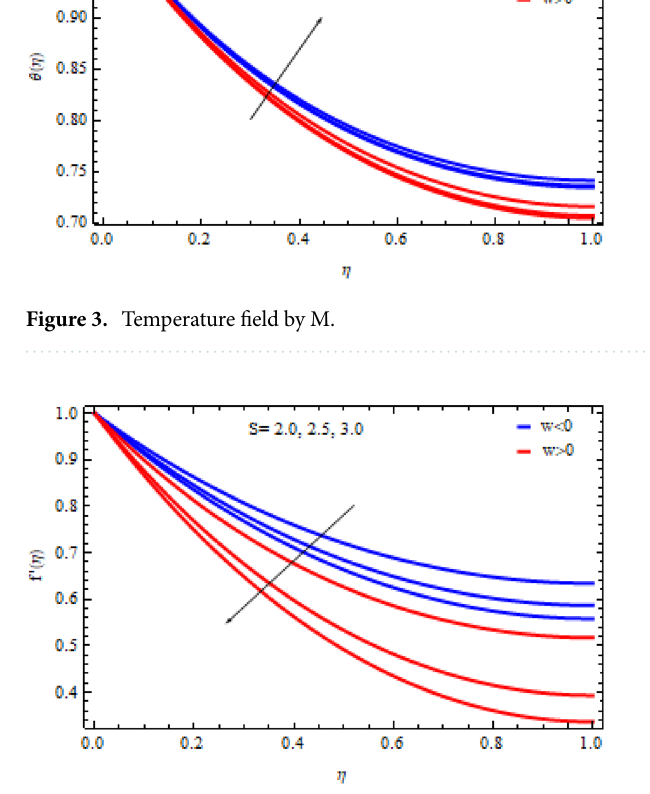
Figure 4. Velocity field by S.